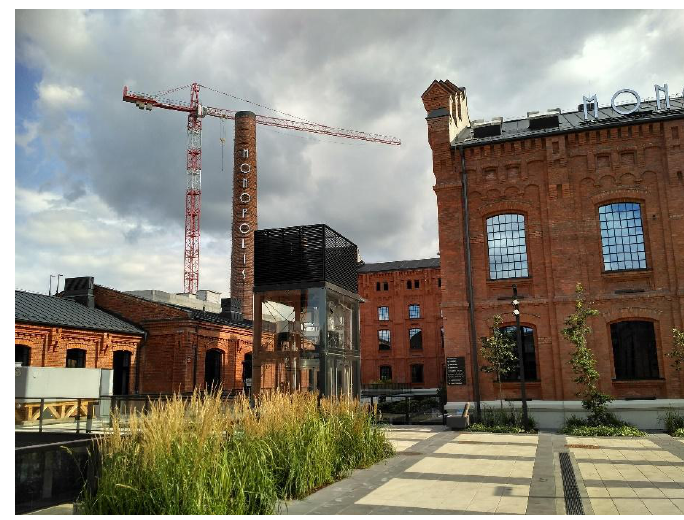
Figure 14. View of the inner courtyard of the “Monopolis” office and entertainment complex.